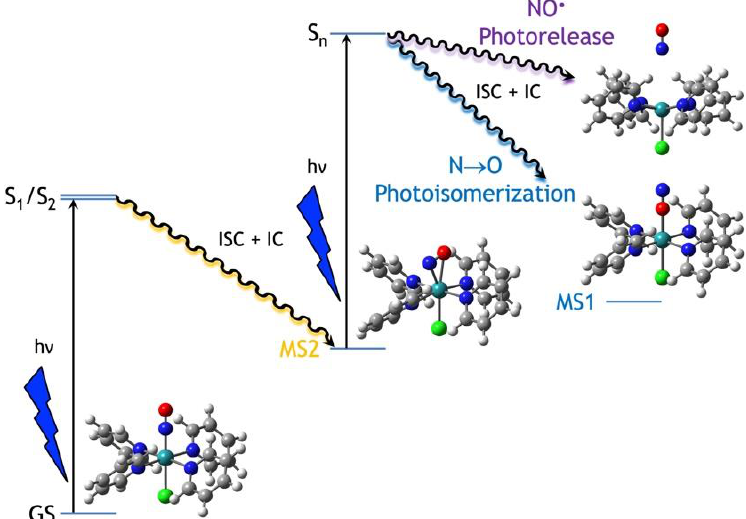
Figure 1. Scheme illustrating the competitive and intricated N → O linkage photoisomerization and NO • photorelease mechanism in the trans- [RuCl(NO)(py) 4 ] 2+ complex. ISC: intersystem crossing. IC: internal